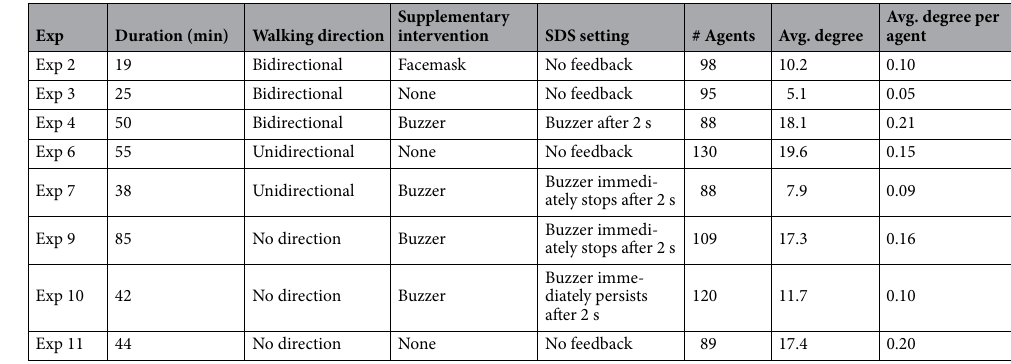
Table 1. Details of the conditions and attributes of the experiments. In the second column (‘Duration’) we note the filtered window durations, rather than the full experiment times. Event amounts and link frequencies are determined using only events with sizes larger than 1. Number of agents may differ from that in Ref. 42 because we focus on only a part of each experiment (see Fig. A.1). The average degree and the average degree per agent have been calculated from the aggregated contact network, aggregated over the full valid duration of the